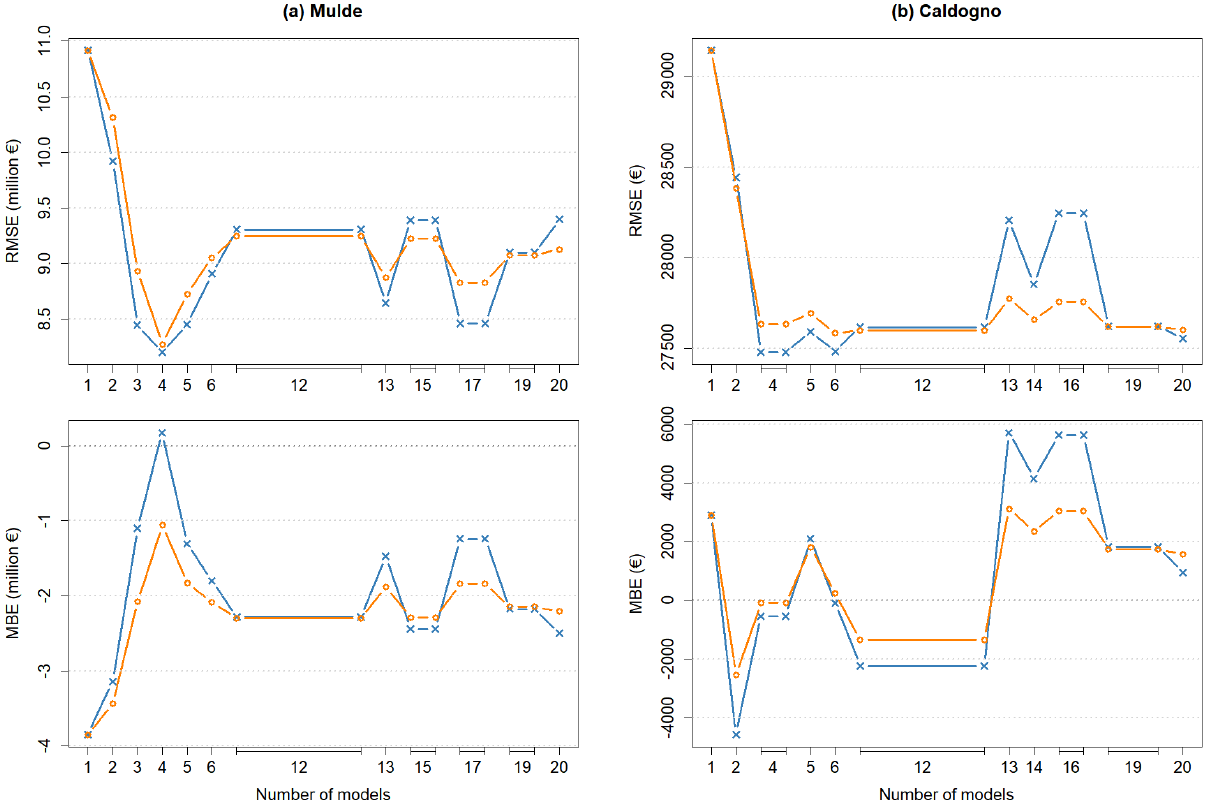
Figure 4. Root mean square error (RMSE) and mean bias error (MBE) of the means of ensembles of increasing size, with models included sequentially from highest to lowest score, starting with the highest ranked single model. Blue crosses and orange circles refer to ensembles weighted equally and differently,